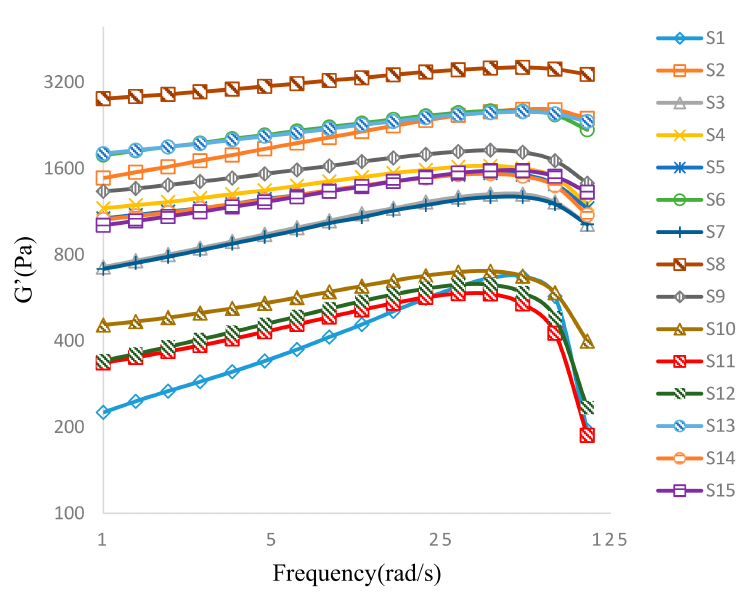
Figure 3. Evolution of G’ as a function of the applied frequency for samples of felbinac